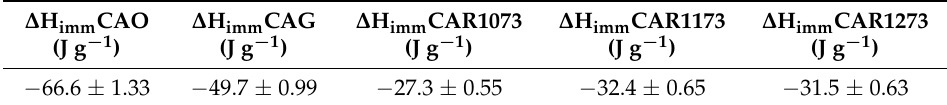
Table 6. Immersion enthalpy in water for activated carbons CAO, CAG, CAR1073, CAR1173, and CAR1273.